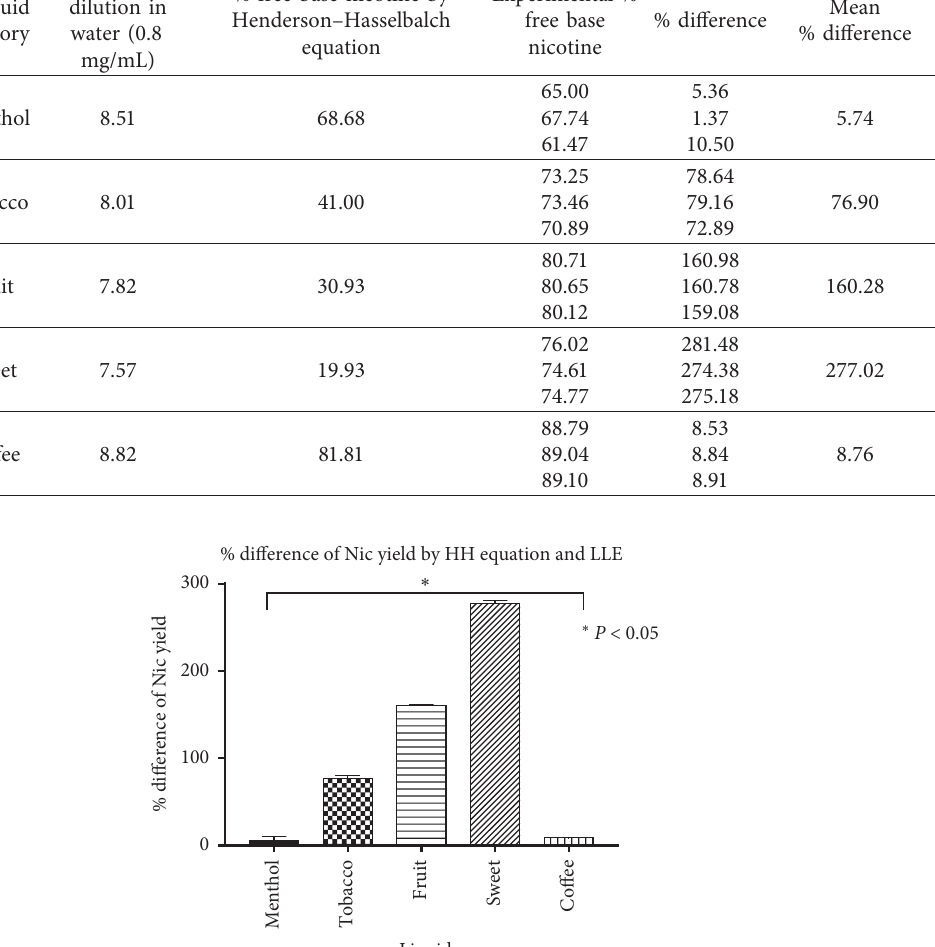
Table 4: Determination of free base nicotine in e-liquid samples by toluene-water double extraction. e-Liquid